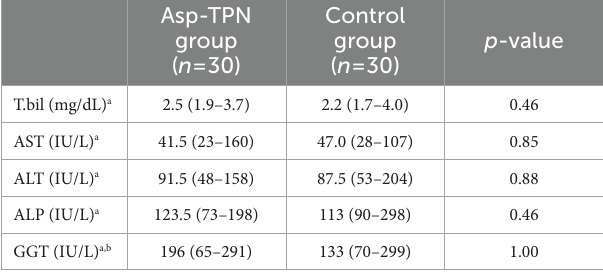
TABLE 3 Peak level of liver function test (LFT) results.